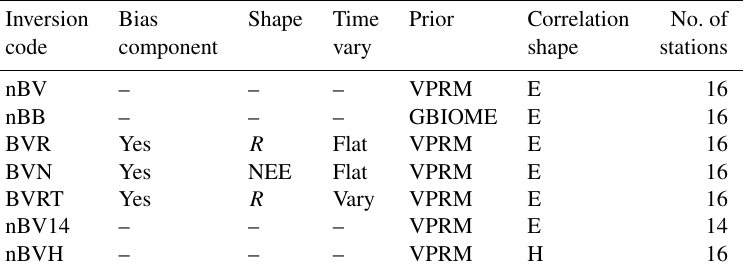
Glossaryforthedataprovidersareasfollows.AGH:UniversityofScienceandTechnologyPoland;ECN:EnergyresearchCentreoftheNetherlands;HMS:HungarianMeteorologicalService;IAFMS:ItalianAirForce MeteorologicalService;LSCE:LeLaboratoiredesSciencesduClimatetdel’Environnement;MPI-BGC:MaxPlanckInstituteforBiogeochemistry;NOAA:NationalOceanicandAtmosphericAdministration;RSE:Ricercasul SistemaEnergetico;UBA:Umweltbundesamt;UKRAK:DepartmentofEnvironmentalPhysicsPoland. Table 2. Overview of the inversion scenarios. “Shape” describes the internal structure of the bias component (proportional to respiration R or to net ecosystem exchange, NEE), and “Time vary” indicates whether the bias component also has temporal variations or not. The fifth column “Prior” represents the terrestrial model used as prior, and “Correlation shape” describes the functional form used for the spatial prior uncertainty correlation, either exponential (E) or hyperbolic (H). The last column indicates whether the full or the reduced station network was